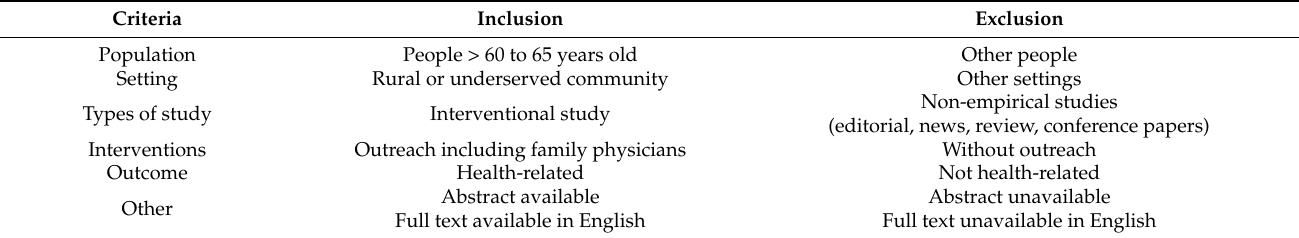
Table 1. Inclusion and exclusion